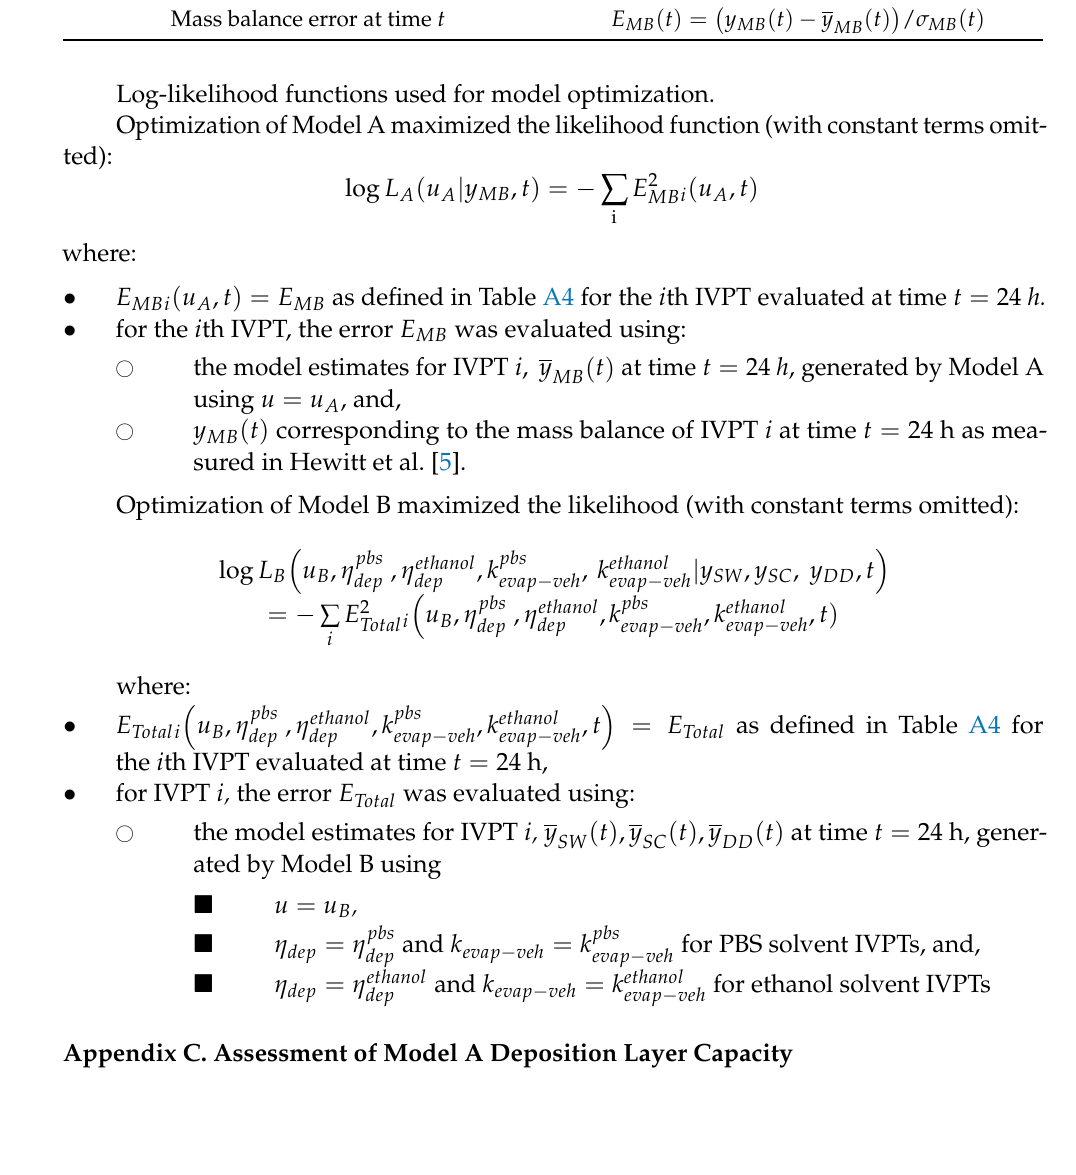
Table A4. Definition of measures of model error. See Table A3 for definitions of model estimates. Quantity Definition Skin wash error at time t e SW ( t ) = Stratum corneum accumulation error at time t e SC ( t ) = Cumulative dermal delivery error at time t e DD ( t ) = ( y DD ( t ) − y Root sum of squares error at time t Mass balance error at time t E MB ( t ) =